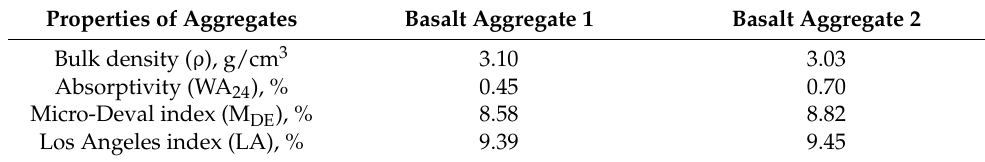
Table 1. Average physical and mechanical properties values of two basaltic